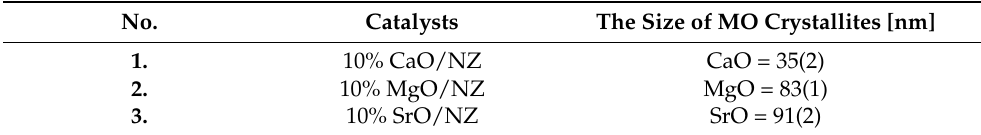
Table 4. Size of metal oxide crystallites estimated by the Scherrer method for the selected peaks from XRD measurements performed for metal-oxide catalysts calcined in an air atmosphere at 400 ◦ C for 4 h. No.